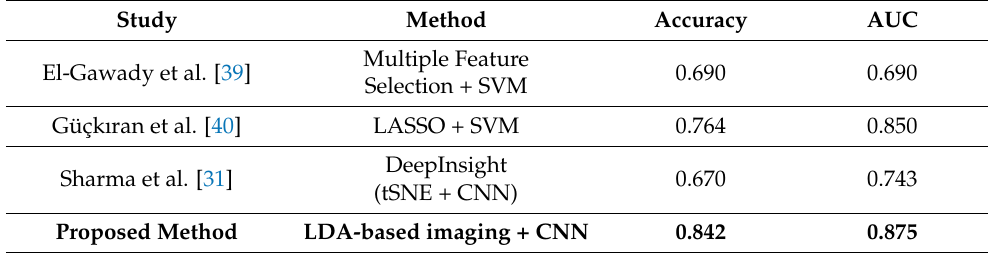
Table 2. Results obtained with four different implementations using the same combined dataset.